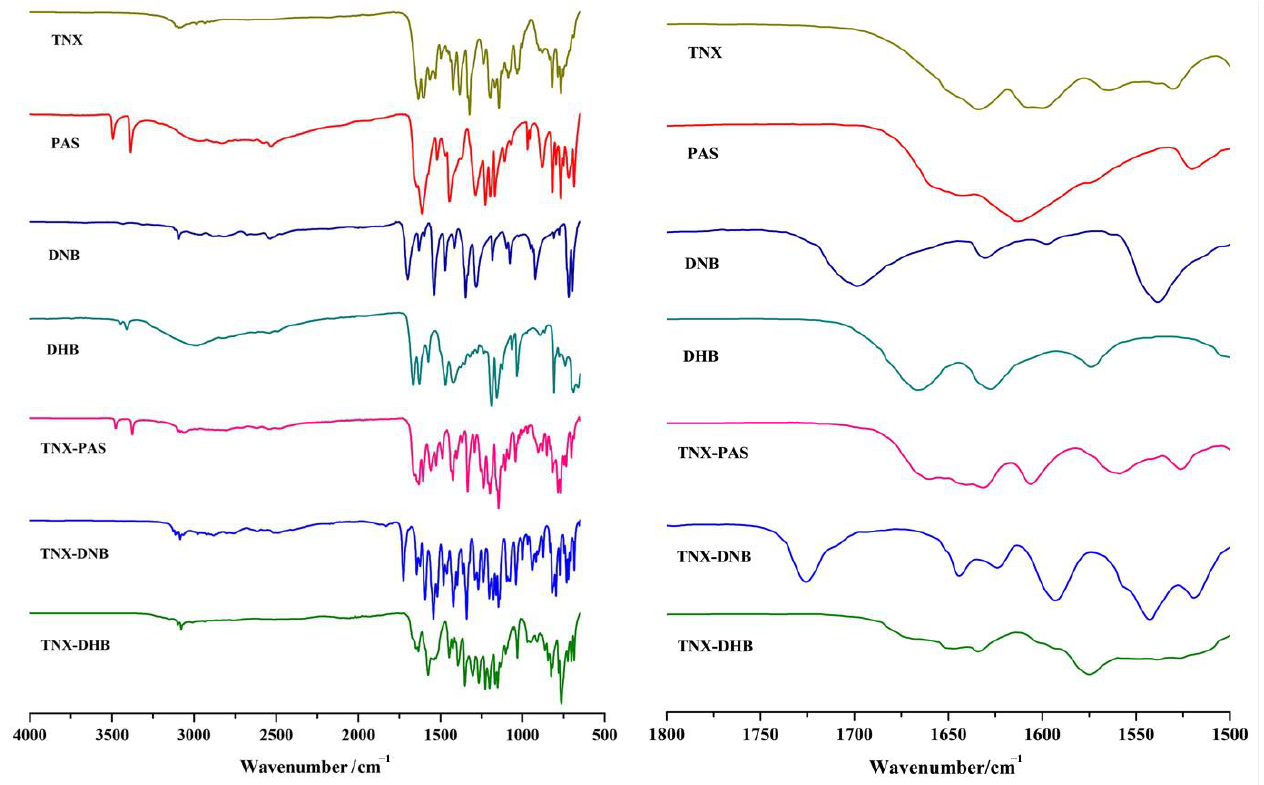
Figure 4. IR spectra of TNX, CCFs, and the corresponding cocrystals/salt ( left ); the region for OH stretch in IR spectra of TNX, CCFs, and the corresponding cocrystals/salt ( right ).